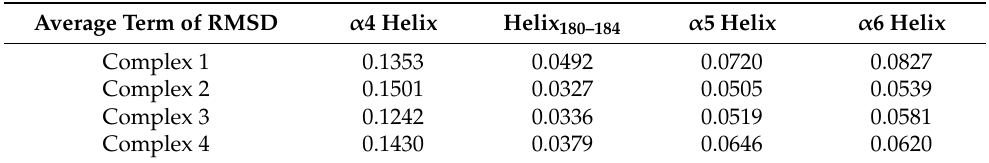
Figure 8. Enlarged detail showing the direction of the tail benzene ring in the four complexes, ( a ) superimposed diagram of the four complexes, ( b – e ) detail of the four complexes in the benzene ring direction.